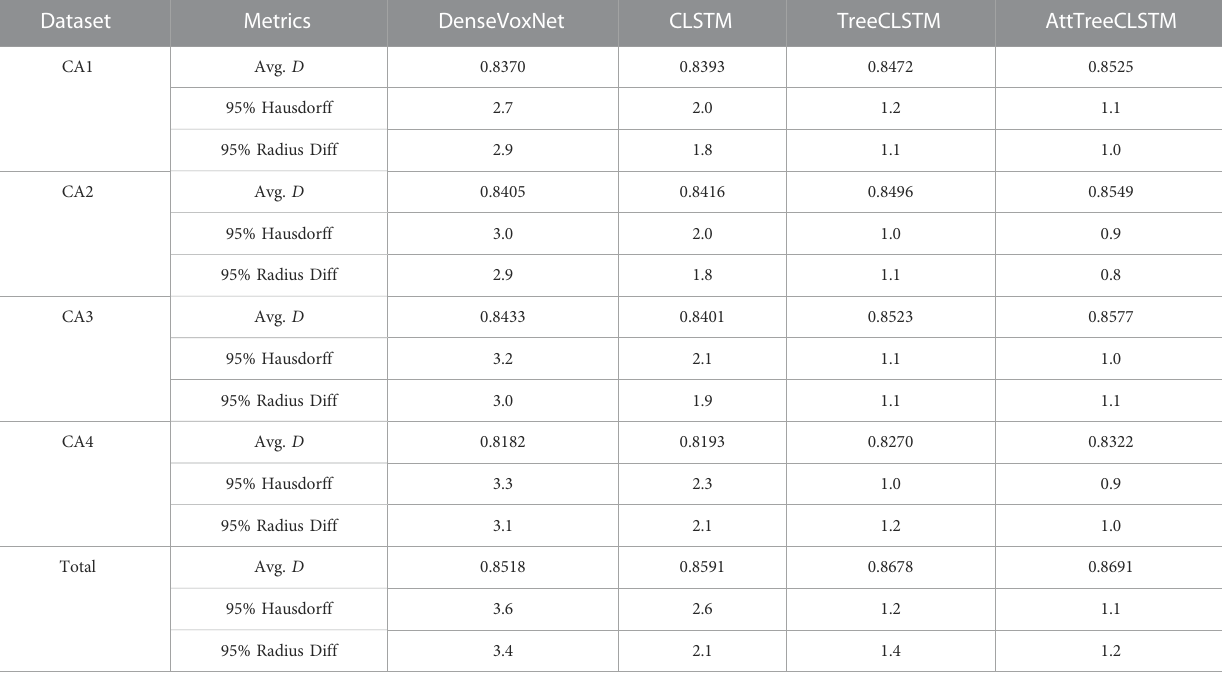
TABLE 3 Comparison of 3D densely-connected volumetric convnets (DenseVoxNet) Yu et al. [48], sequential ConvLSTM (CLSTM) Shi et al. [1], tree-structured ConvLSTM (TreeCLSTM), and tree-structured ConvLSTM with attention (AttTreeCLSTM) in terms of Ave. D , 95% Hausdorff, and 95% Radius Difference. Dataset